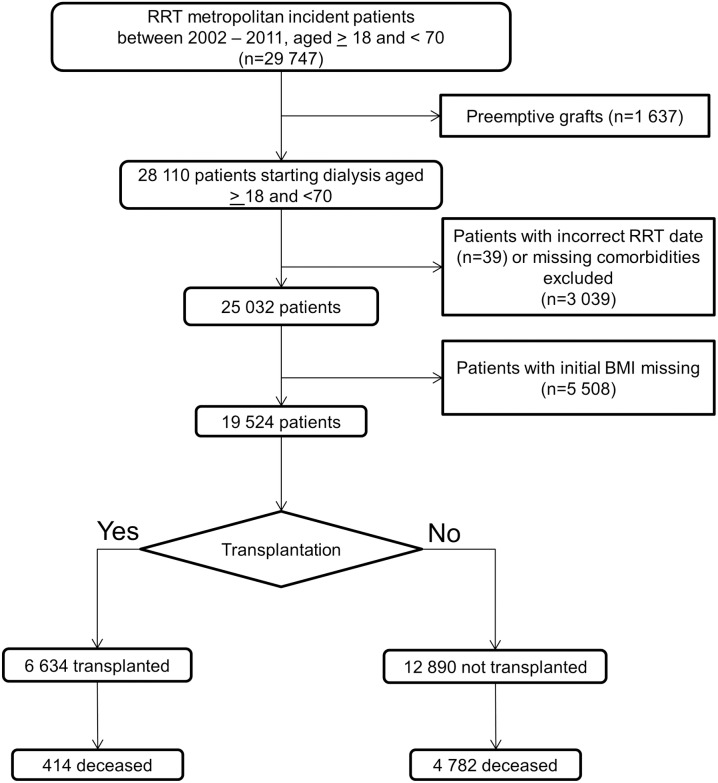
Flow chart for sample selection (RRT: Renal replacement therapy).Relative to the excluded patients, the included patients did not differ significantly in terms of gender and the prevalence of congestive heart failure but were older (+1 year, p<0.001), had a slight lower eGFR at initiation (-0.2ml/min, p = 0.03), were less likely to have diabetes (-2%, p<0.002) and had different patterns of initially treated conditions or primary renal disease (Table A in S1 File).